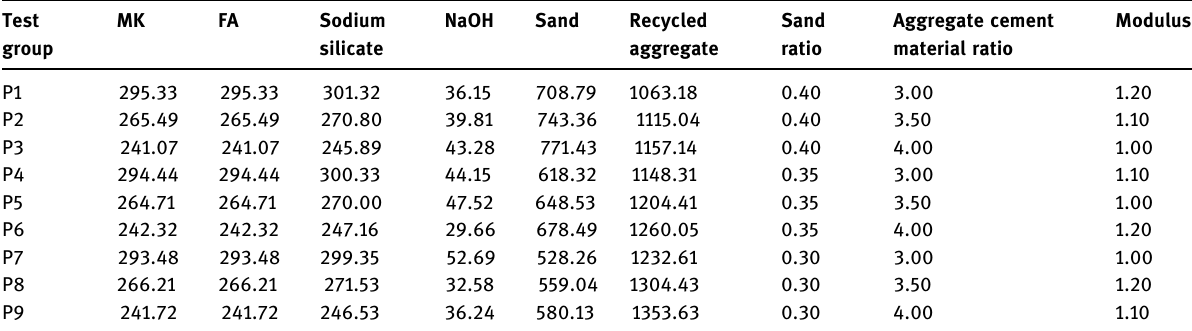
Table 4: Design table of GRAC mix proportion ( kg · m − 3 )